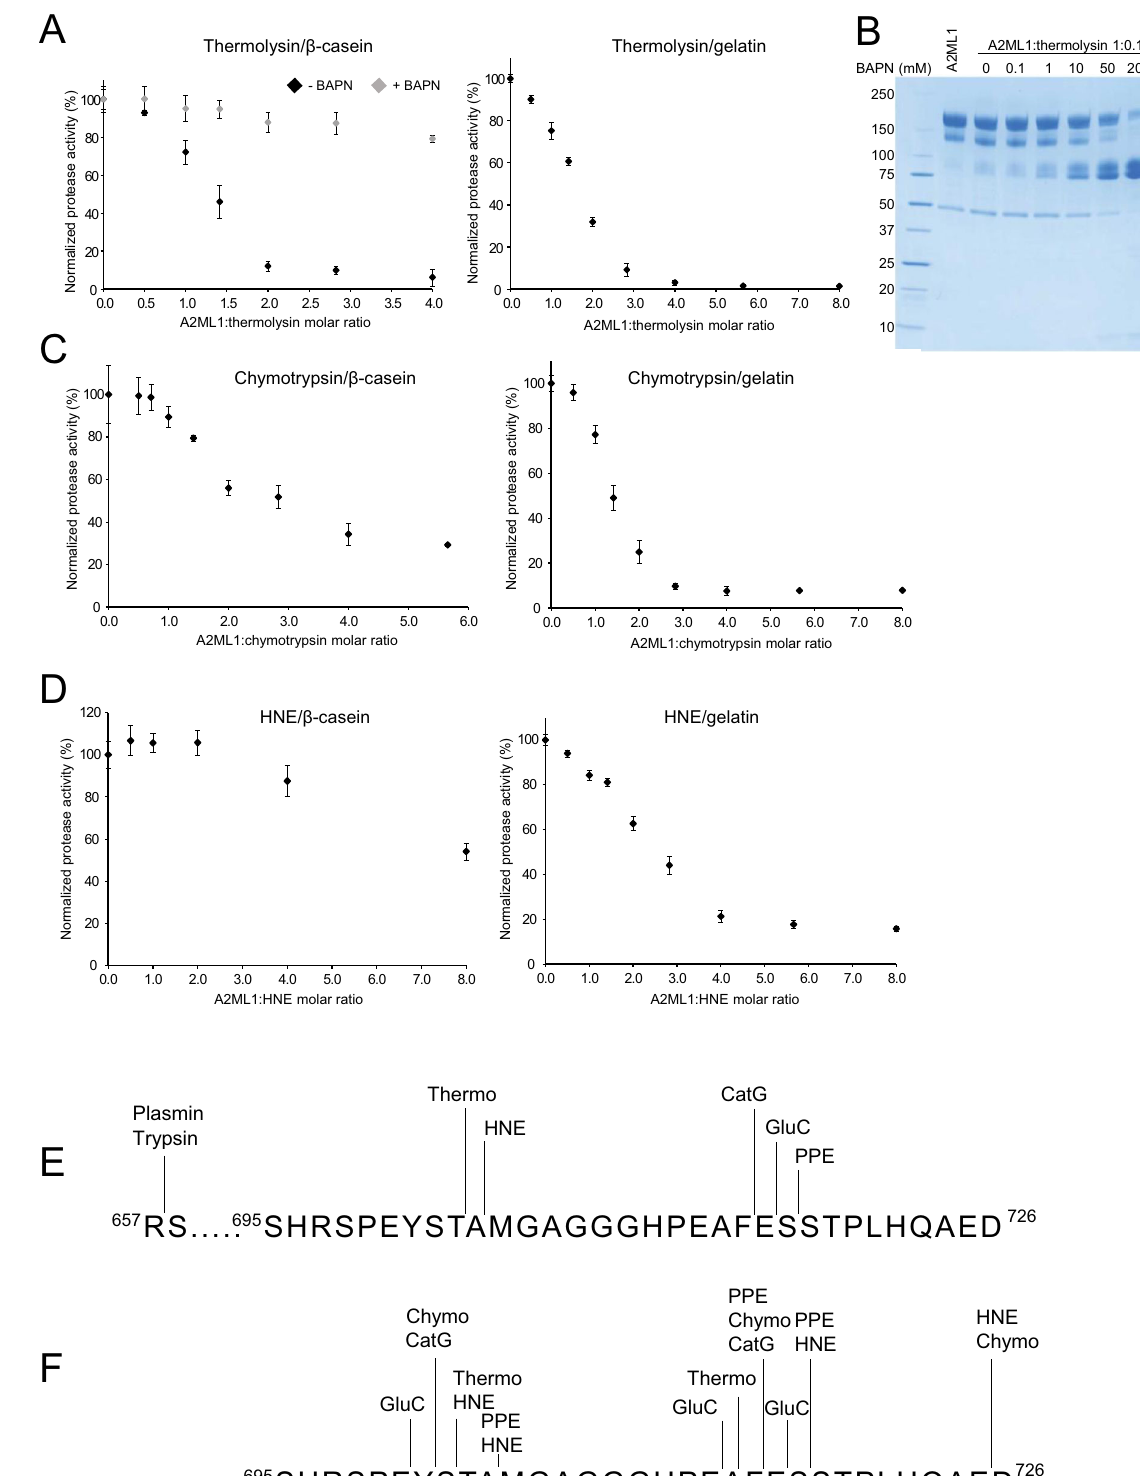
Chymotrypsin/gelatinChymotrypsin/β-casein